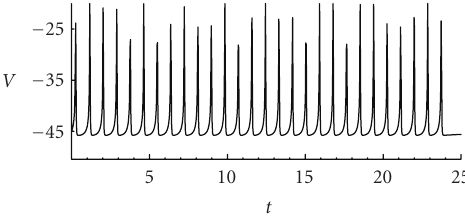
Figure 2.2. Time sequence of membrane potentials for g K , C = 10 . 0 s − 1 (rhythmic single spiking).